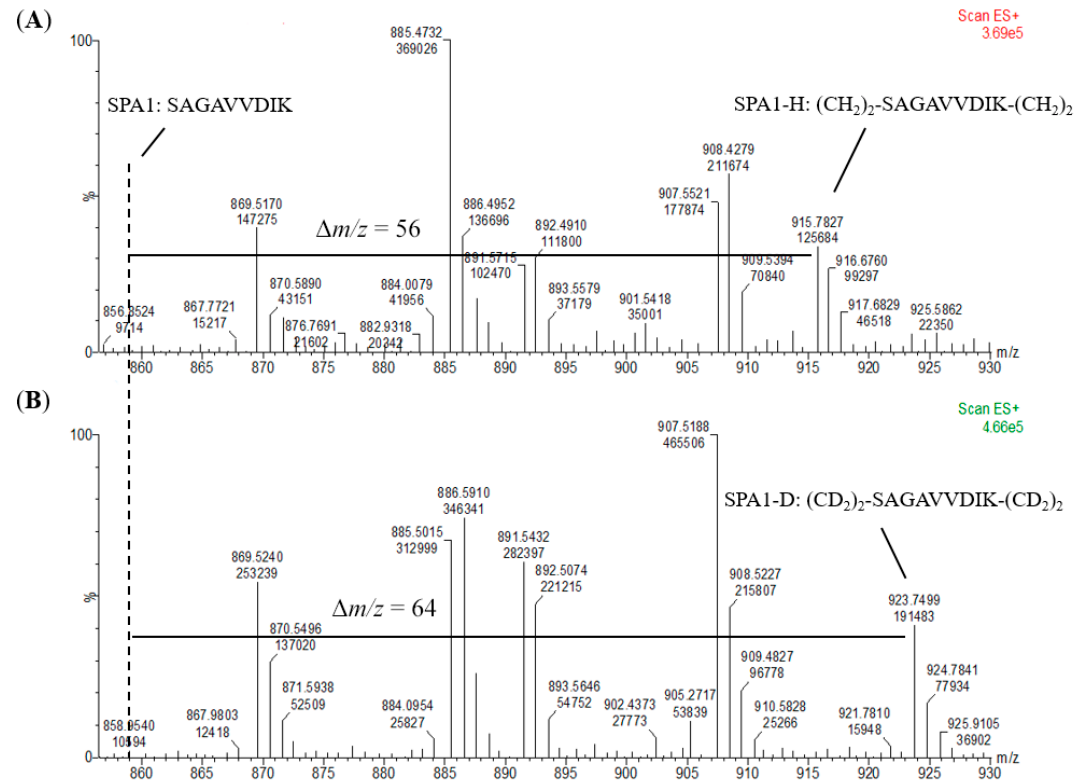
Figure 4. Mass spectra of ( A ) SPA1-H and ( B ) SPA1-D. The dotted line represents the m / z of SPA1 and ∆ m / z shows the m / z shift of the signature peptide before and after stable-isotope dimethyl